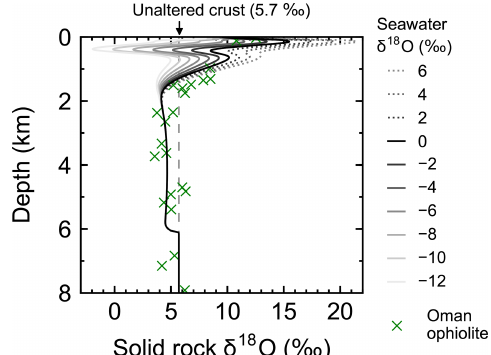
Figure 4. Solid rock δ 18 O as a function of depth at 1Myr (30km) from the ridge axis at seawater δ 18 O values of 6‰, 4‰, ..., − 12‰. Also plotted are Oman ophiolite data from Gregory and Taylor (1981, crosses) converting their reported depth y (cid:48) (km) to 7 . 4 − y (cid:48) (km) to facilitate comparison.